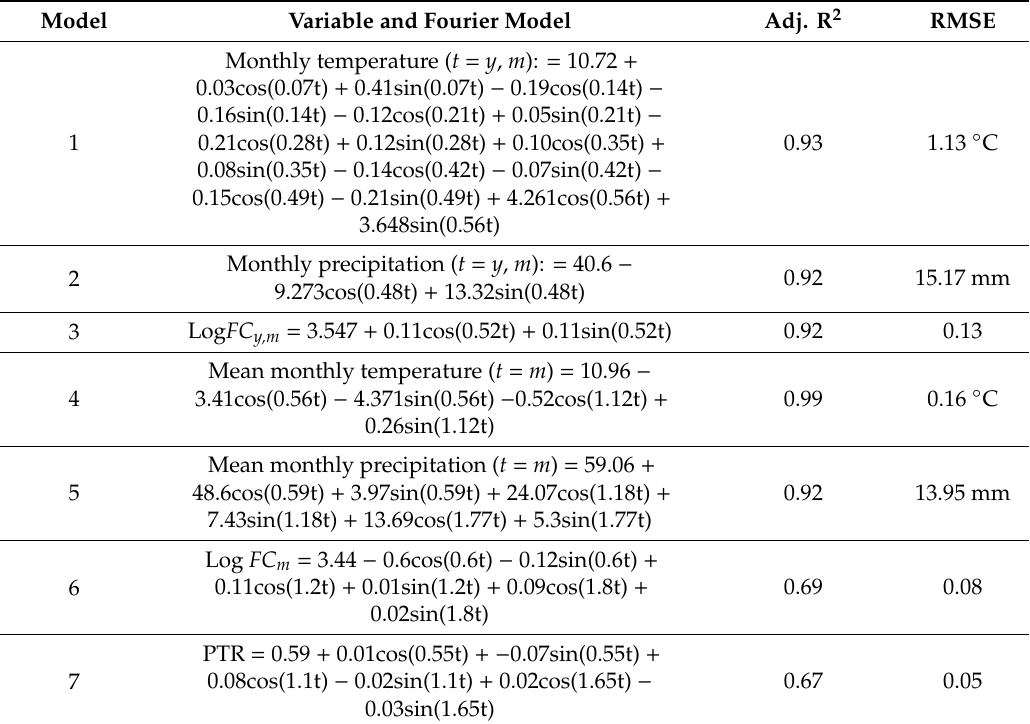
Table 1. Fourier Coe ffi